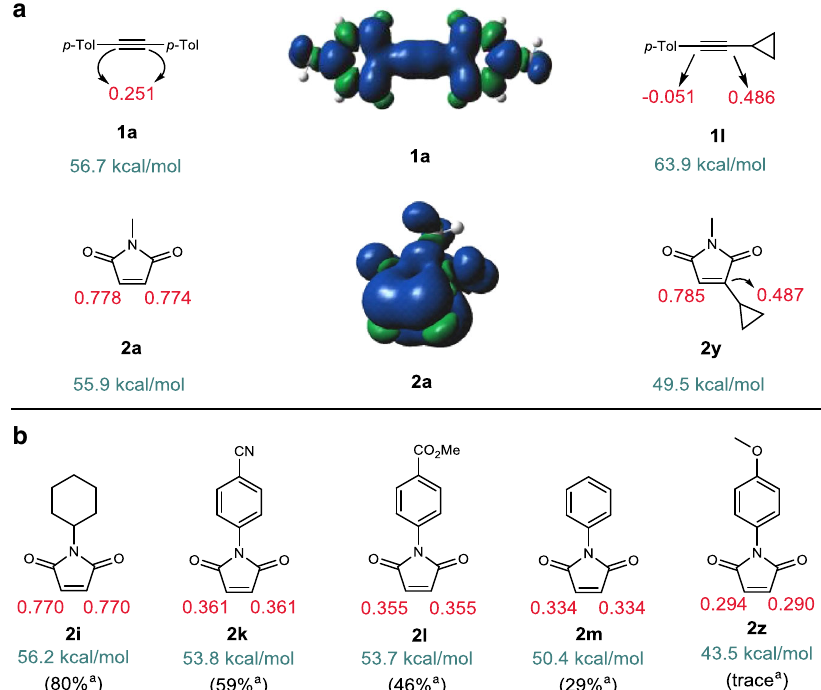
Fig. 7 Mulliken spin densities (T 1 ) and triplet-singlet energy gaps of selected substrates. a Reactions were conducted with the standard condition using di( p -tolyl)acetylene 1a (0.1 mmol). a Spin densities and surfaces of 1a and 2a ; Spin densities of cyclopropyl derivatives 1l and 2y . b Correlation of spin densities and reaction ef fi ciencies of N -substituted maleimides.